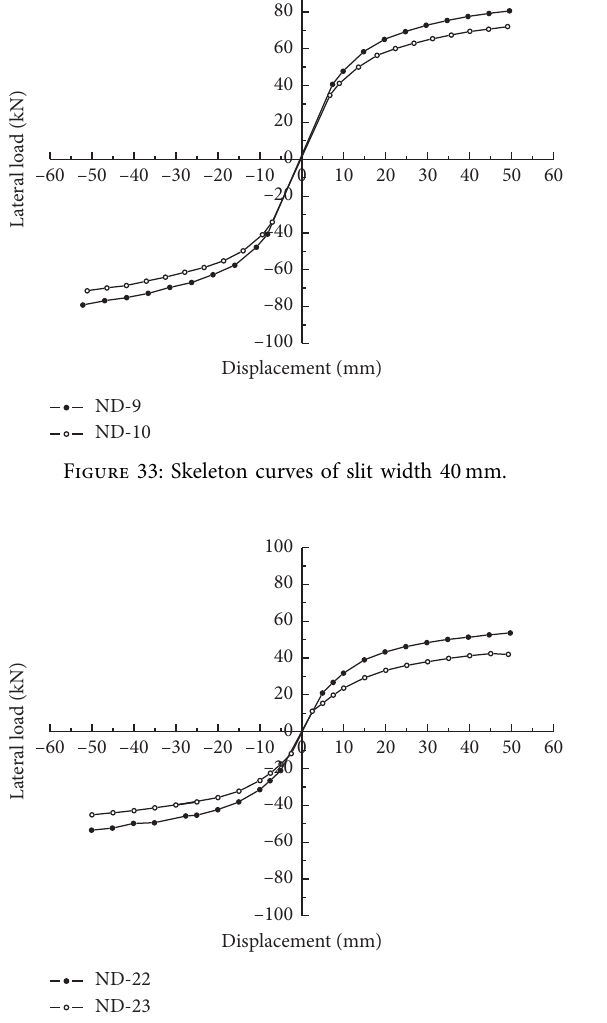
Figure 34: Skeleton curves of slit width